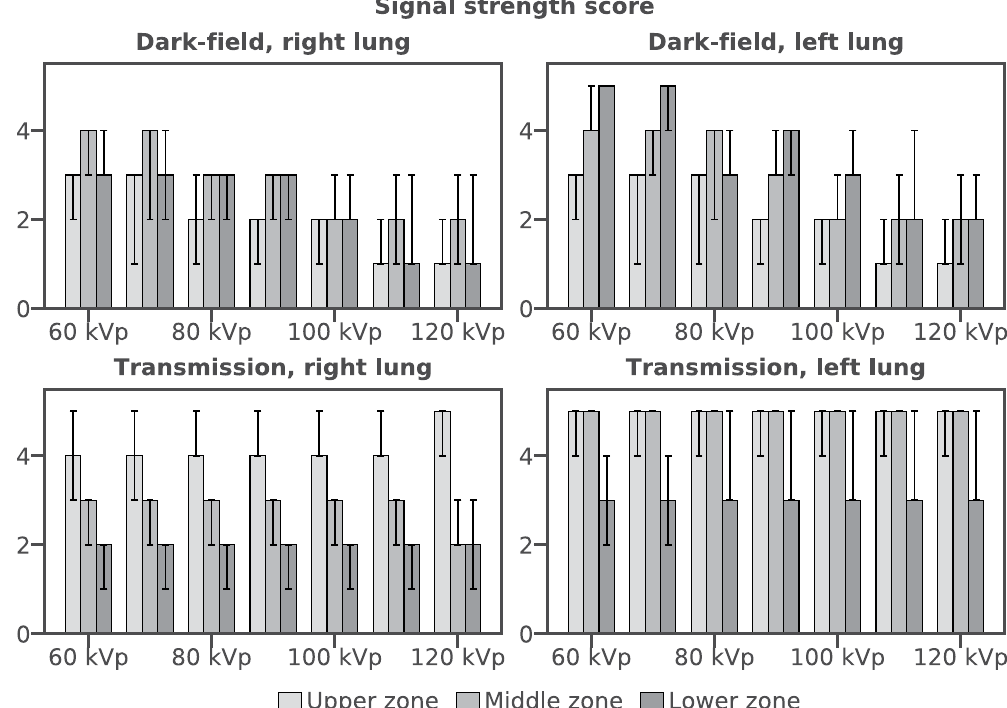
Figure 3. Signal strength score (median and range) of dark-field (top row) and transmission (bottom row) images for the examined tube voltages. Signal strength score in dark-field images increases from the upper left towards the lower left lung, as the projected thickness of the lung increases. In the right lung, this effect is counteracted by an infiltrate in the lower right lung. In every examined zone, signal strength score decreases for increasing tube voltages. In transmission, signal strength score decreases from the upper lungs to the lower lungs. In every examined zone, the score remains nearly constant for all tube voltages.